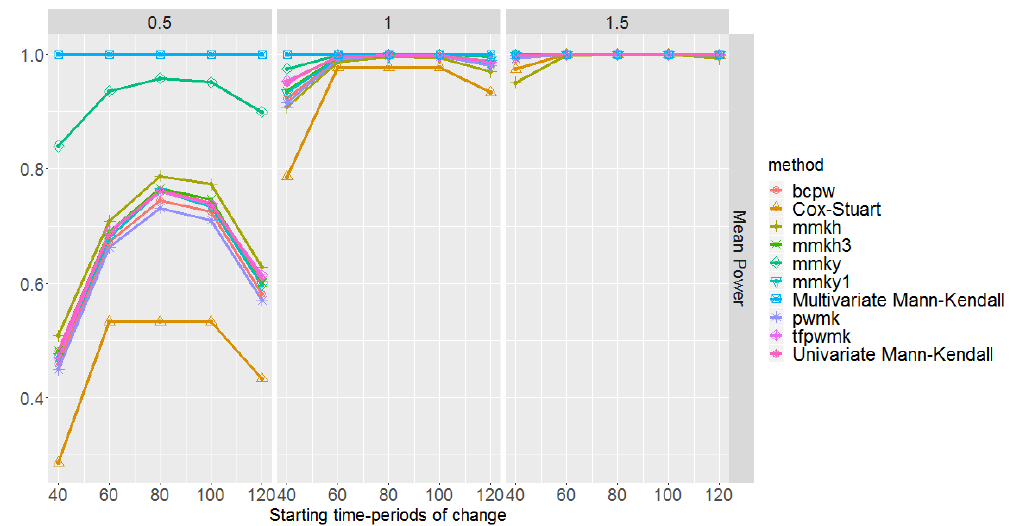
Figure 6. Mean empirical power of the tests of the trend detection methods with respect to the magnitudes of change 0.5,1, and 1.5, and starting time-periods of change 40,60, . . . ,120. These are based on 100 simulations of multi-layer rasters under the first scenario, where pixel time series are generated from the standard normal distributions.